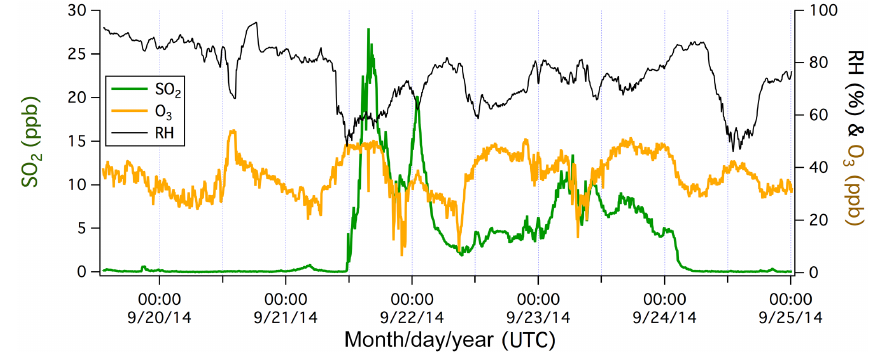
Figure A1. Very high SO 2 mixing ratios were observed in Icelandic volcano plumes. Elevated SO 2 sometimes coincided with increased O 3 and reduced relative humidity (RH), consistent with entrainment from the free